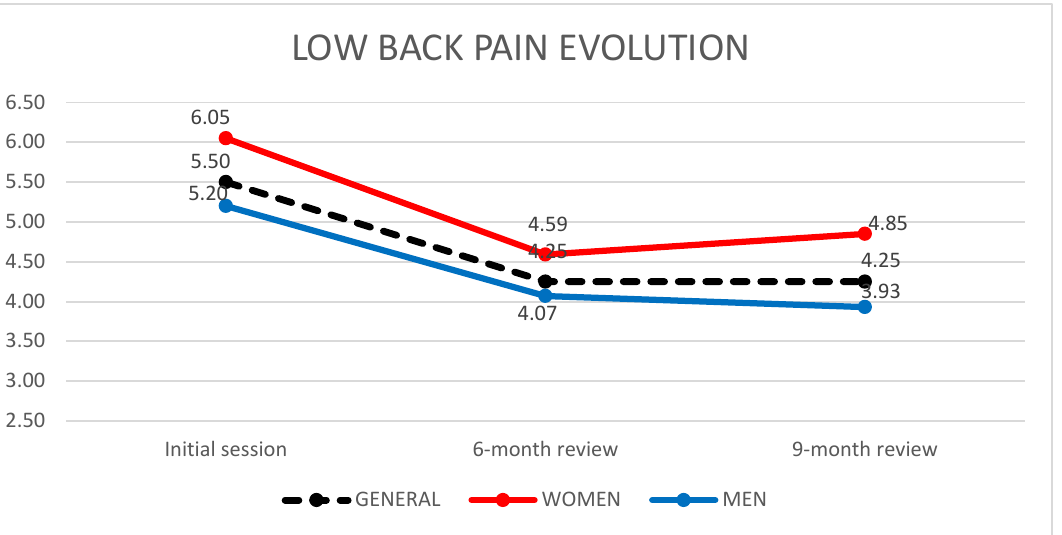
Figure 2. Evolution of the average low back pain, according to gender, from the workers’ VAS, carried out in the first session, review at 6 months and review at 9 months. Table 8. Evolution of the mean results of the visual analogue scale for low back pain: first assessment, review at 6 and 9